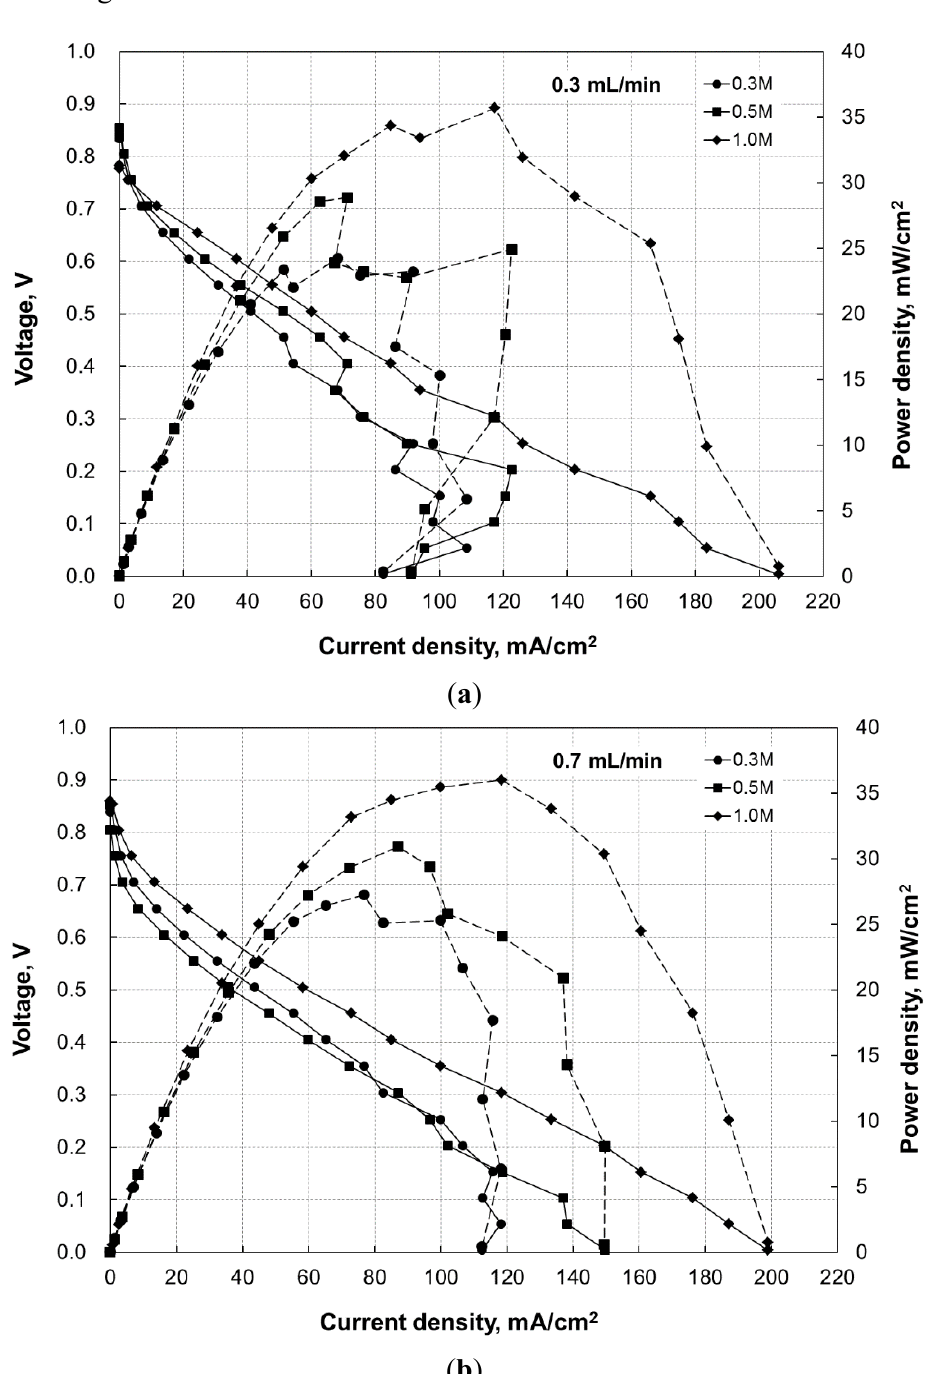
Figure 4. ( a ) V - I (solid line) and P - I (dashed line) curves of the fuel cell operated with [HCOOH] = 0.3, 0.5 M and 1.0 M with a volumetric flow rate of ( a ) 0.3 mL/min or ( b ) 0.7